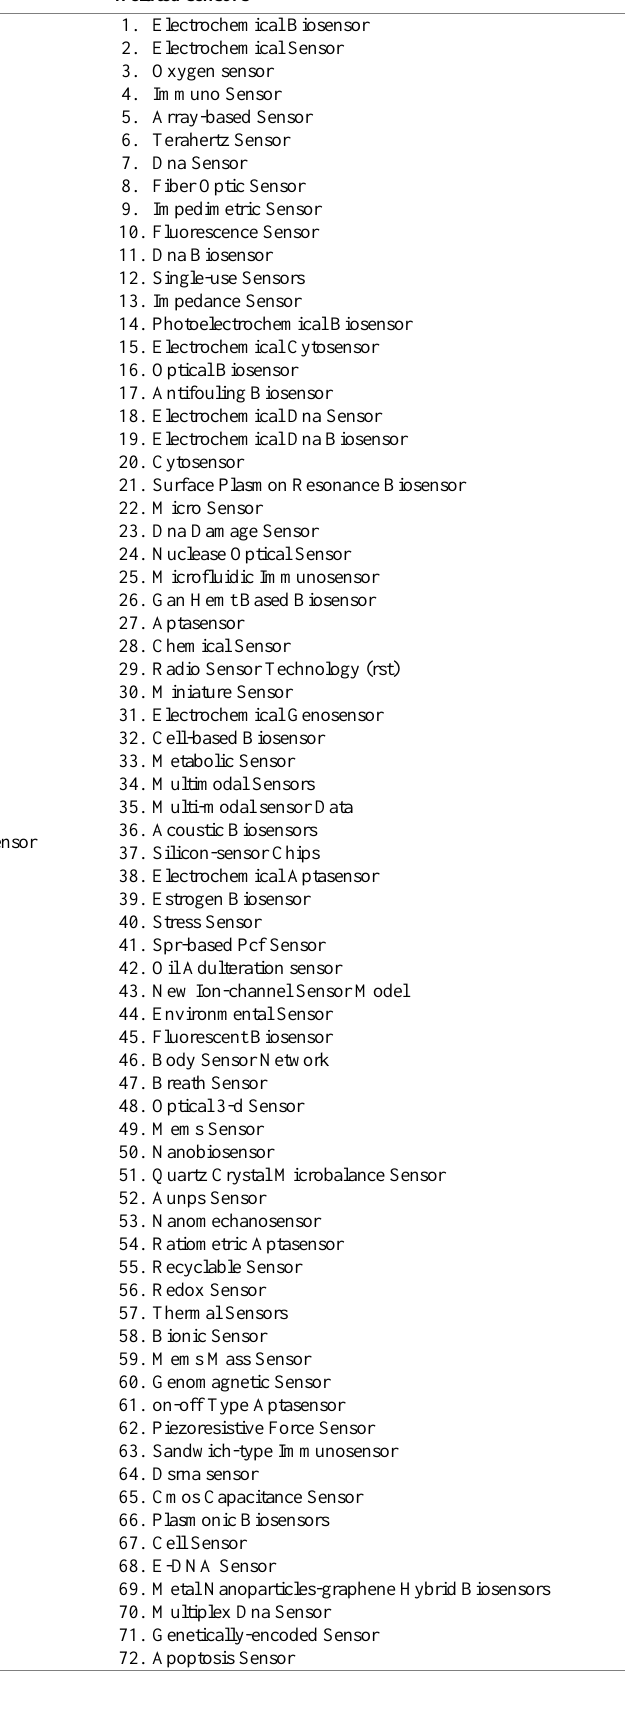
Table 1A. Groups, Core keywords and related sensors in the breast cancer network Group Core Keyword Top 5